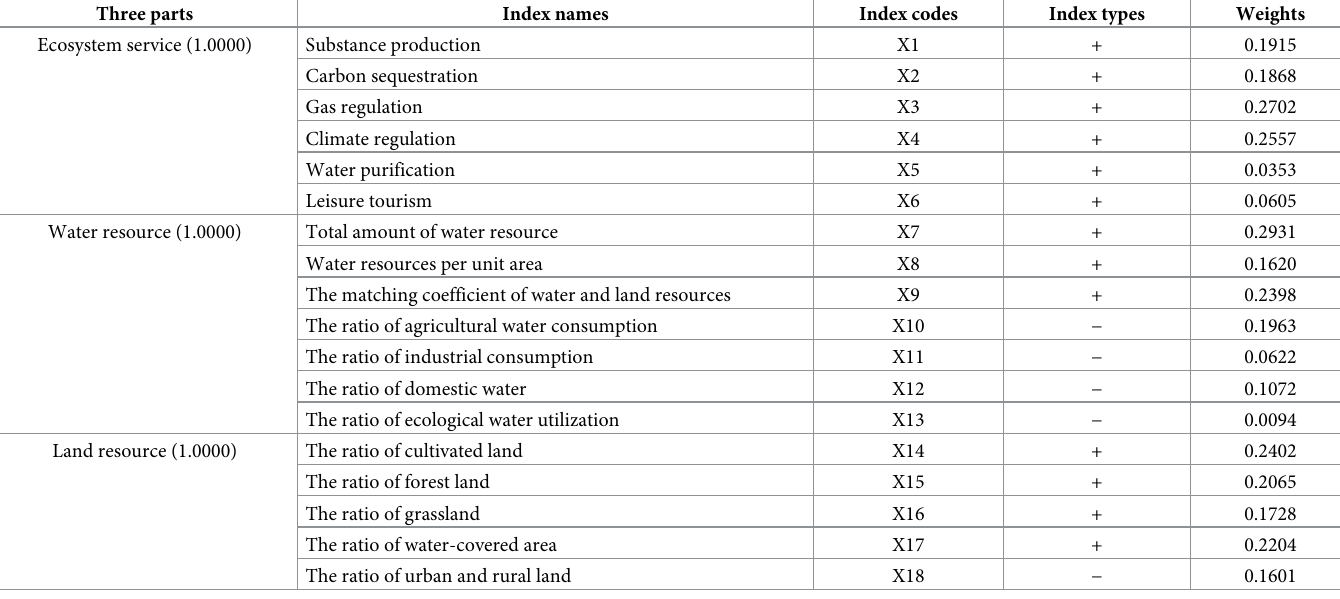
Table 6. Weight of the evaluation